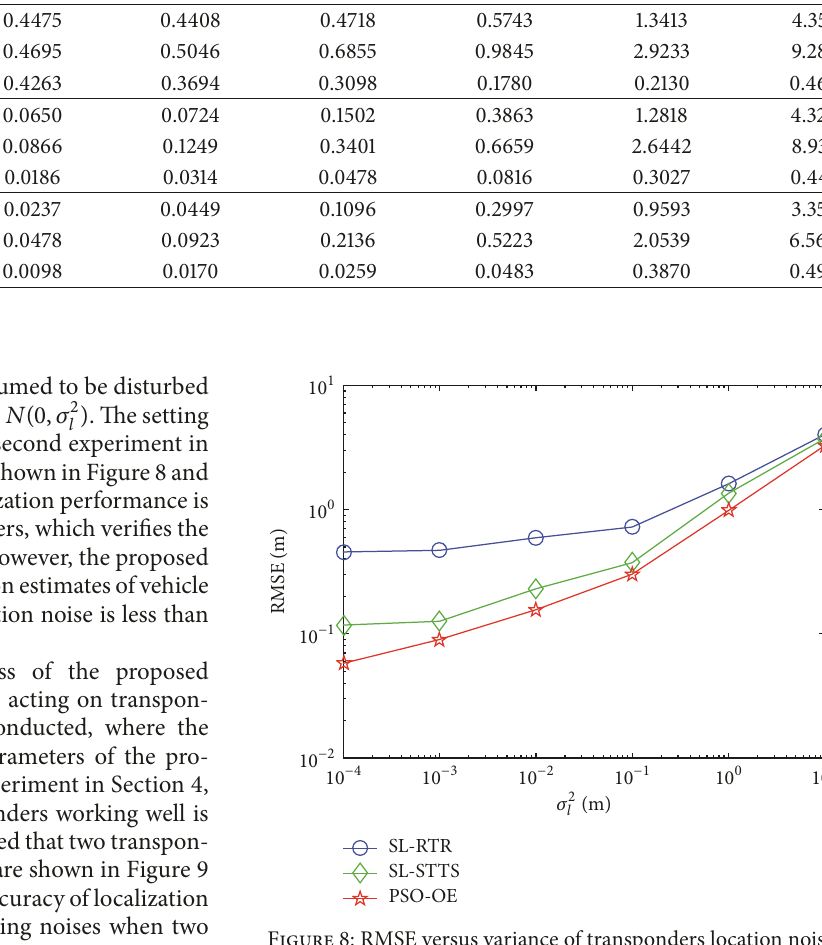
Table 6: The performance indexes of the localization task by different distance measurement noise level, where two transponders failed. The algorithms